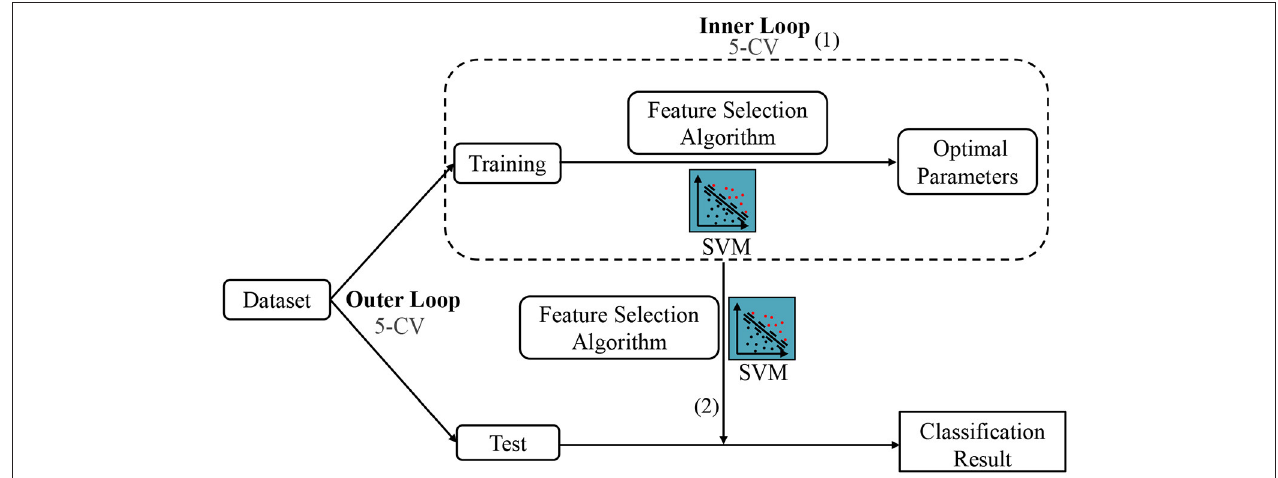
FIGURE 5 | The mechanism of cross-validation in our experiment, including the Inner 5-CV to determine the optimal parameters and the outer 5-CV to get the classification results.